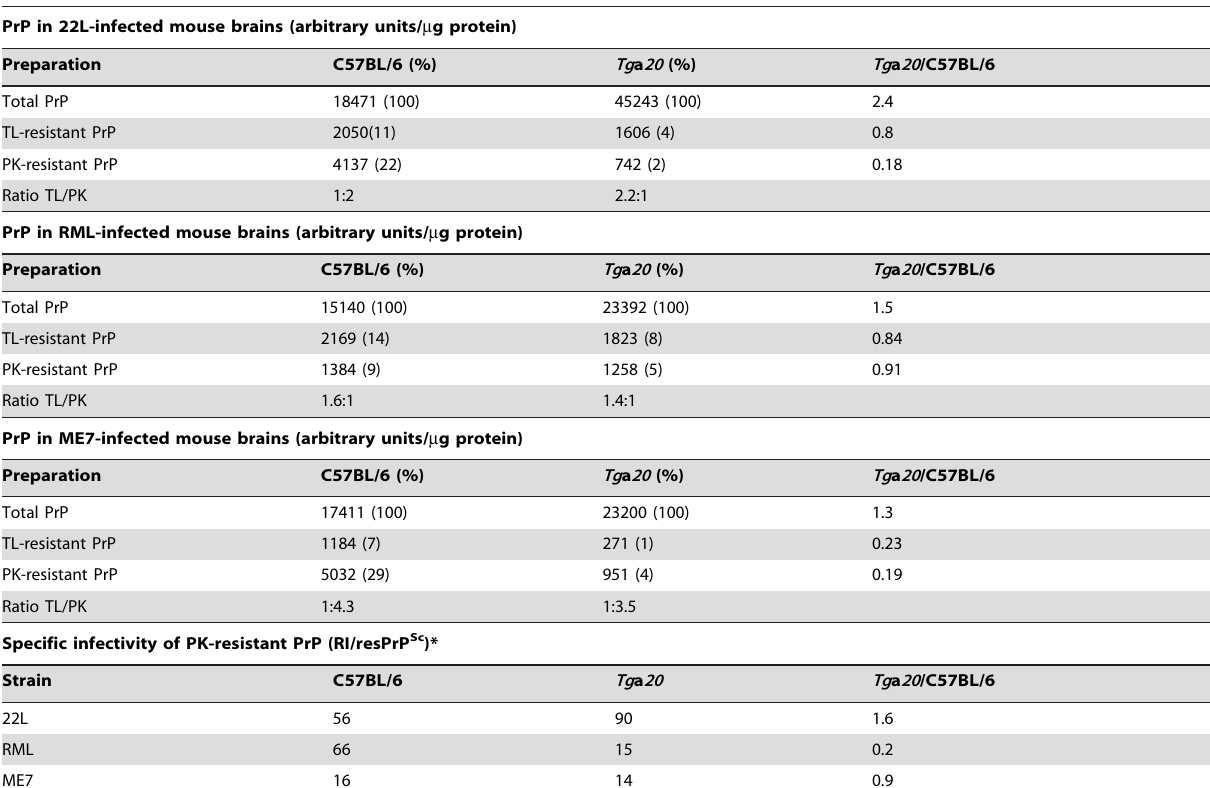
Table 2. PrP levels in prion-infected brains of C57BL/6 and Tg a 20 , and specific infectivities of PK-resistant PrP.